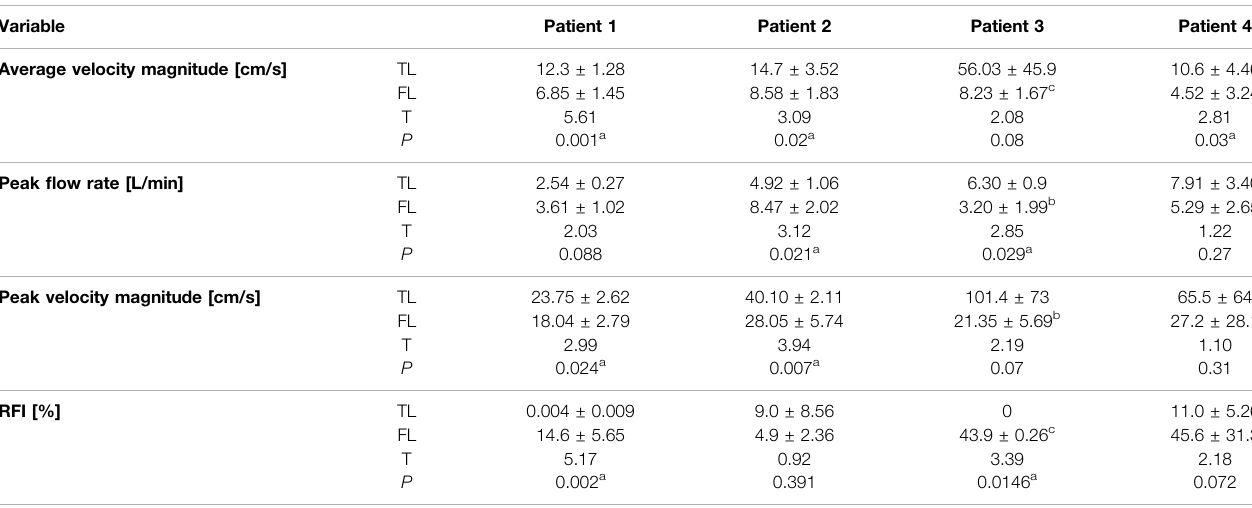
TABLE 3 | Comparison of 4D fl ow analysis in the TL and FL among the four patients.